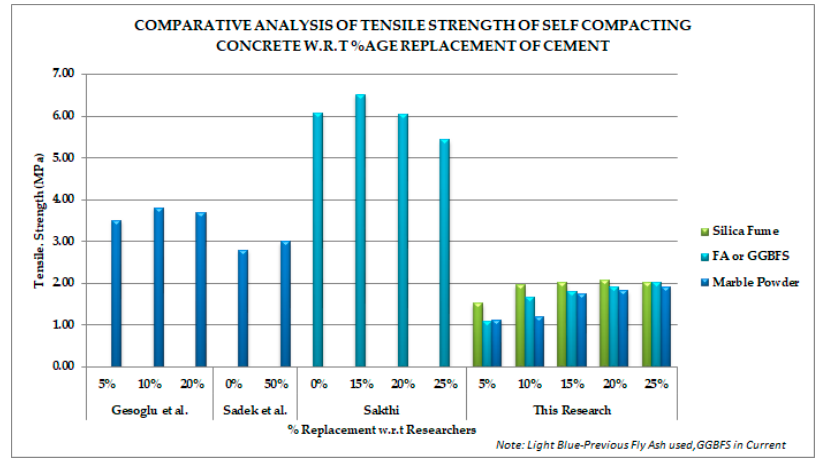
Figure 4. Comparative tensile strength trend with respect to cement replacement of previous studies (Gesoglu [7], Sadek [9] and Sakthi [42]).